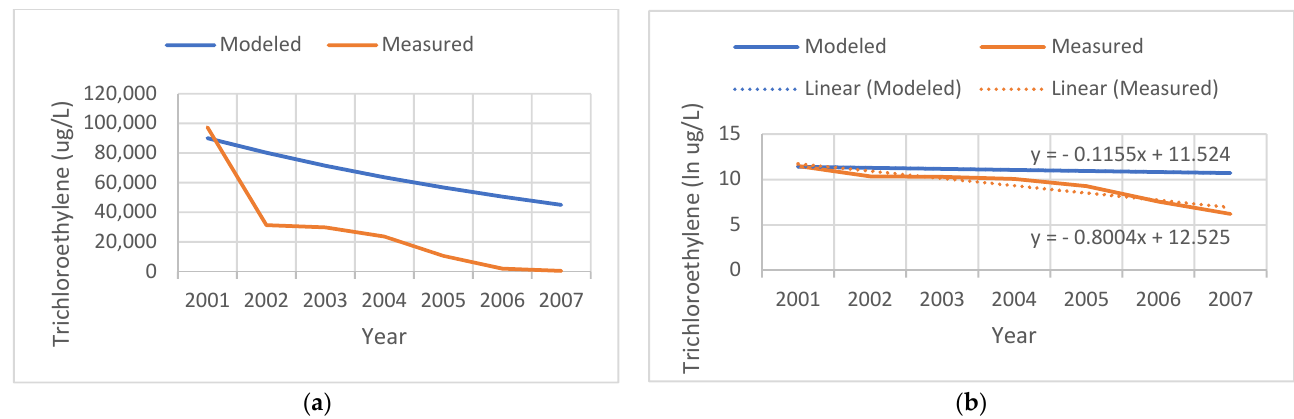
Figure 2. Comparison of the tricholorethylene (TCE) levels modeled (blue) versus measured (red) at a remediated site. ( a ) TCE levels in ug/L. ( b ) Natural log (ln) of TCE levels.